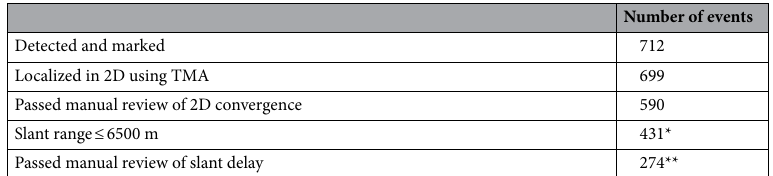
Table 3. Summary of the number of events containing sperm whale usual clicks included in each step of the analysis from click train detection to 3D localization. A single asterisk indicates the number of events used in distance analysis and double asterisks indicates the number of events included in 3D localization and dive depth calculation.